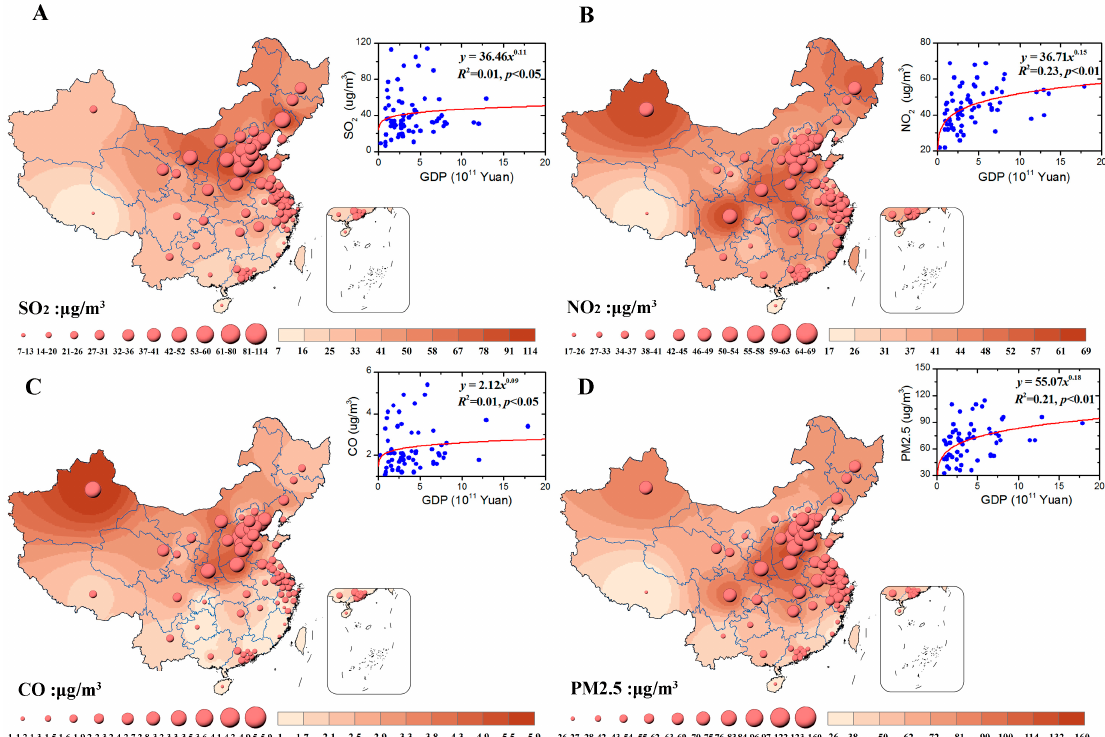
Figure 4. The spatial distributions of the annual density of the SO 2 ( A ); NO 2 ( B ); CO ( C ); and PM 2.5 ( D ) in 2013. The little panels present the relationships of GDP with SO 2 ( A ); NO 2 ( B ); CO ( C ); and PM 2.5 ( D ). The data is extracted from the China Statistical Yearbook on Environment 2014 [10].